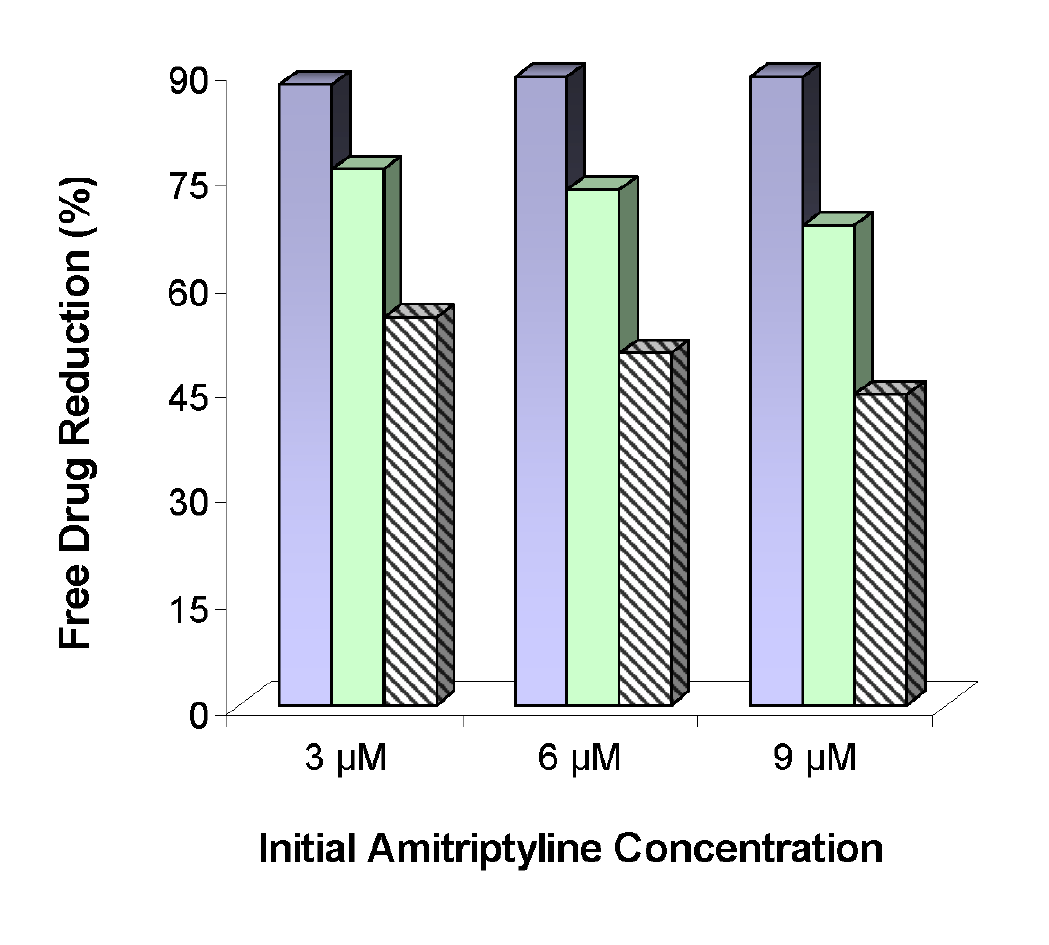
Figure 4. Free drug concentration reductions of amitriptyline in human serum by 95:5 DOPG:DPPE-mPEG-2000 liposomes at loadings of 1.44 ( ) and 0.72 ( ) mg lipid/mL, and 50:50 DMPC:DOPG liposomes ( ) at 0.72 mg lipid/mL. Free drug reductions were calculated based on the differences between free drug concentrations in human serum samples and free drug concentrations in human serum samples mixed with liposomes. Figure adapted from